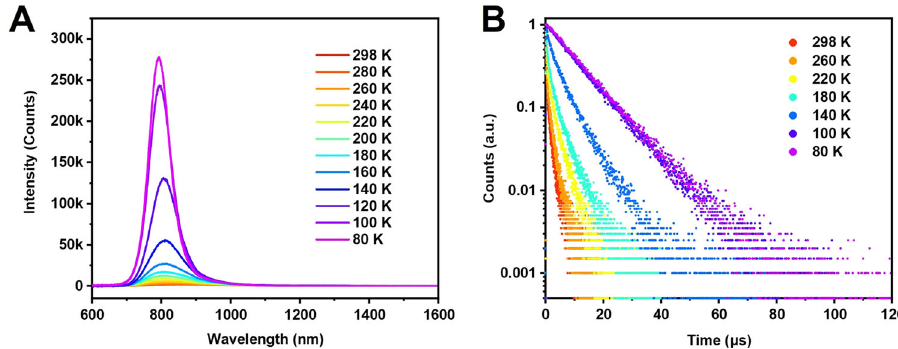
Fig. 3 Cryogenic PL studies. A Temperature-dependent PL spectra of Au 38 (PET) 26 in 2-MeTHF. B Decay pro fi les of Au 38 (PET) 26 in 2-MeTHF at different temperatures. For PL measurements: excitation at 400 nm, slit width 5 nm, and emission slit width 5 nm.